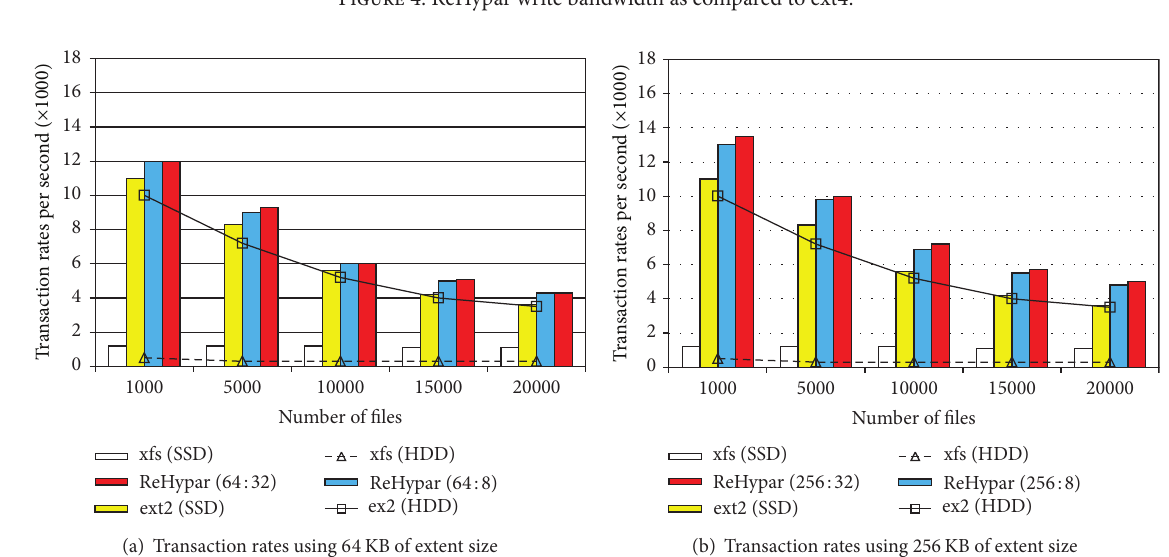
Figure 5: ReHypar transaction rates as compared to ext2 and